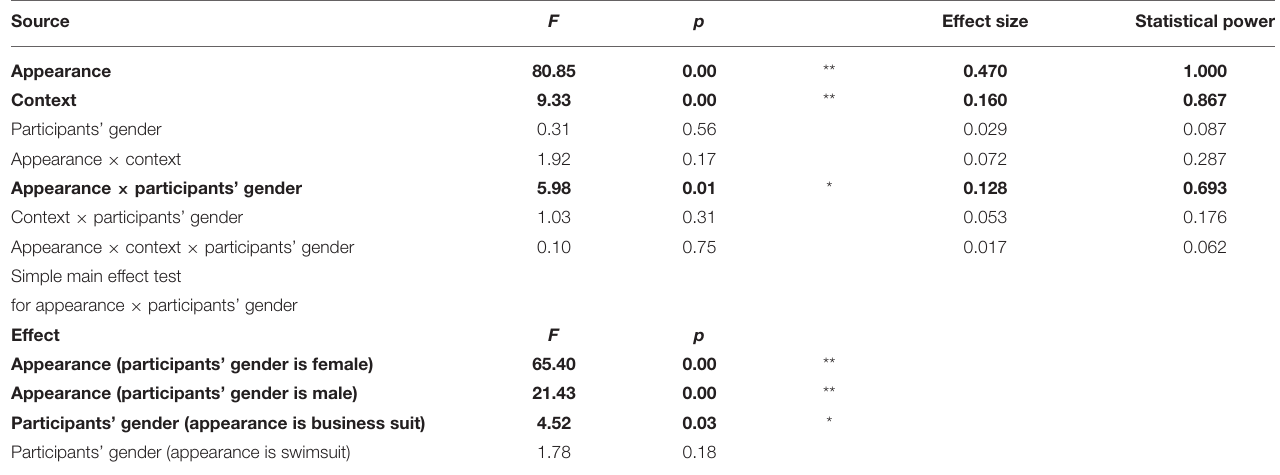
TABLE 9 | Results of three-way ANOVA simple main effect test for appearance × participants’ gender for Q4 (sexuality). Source